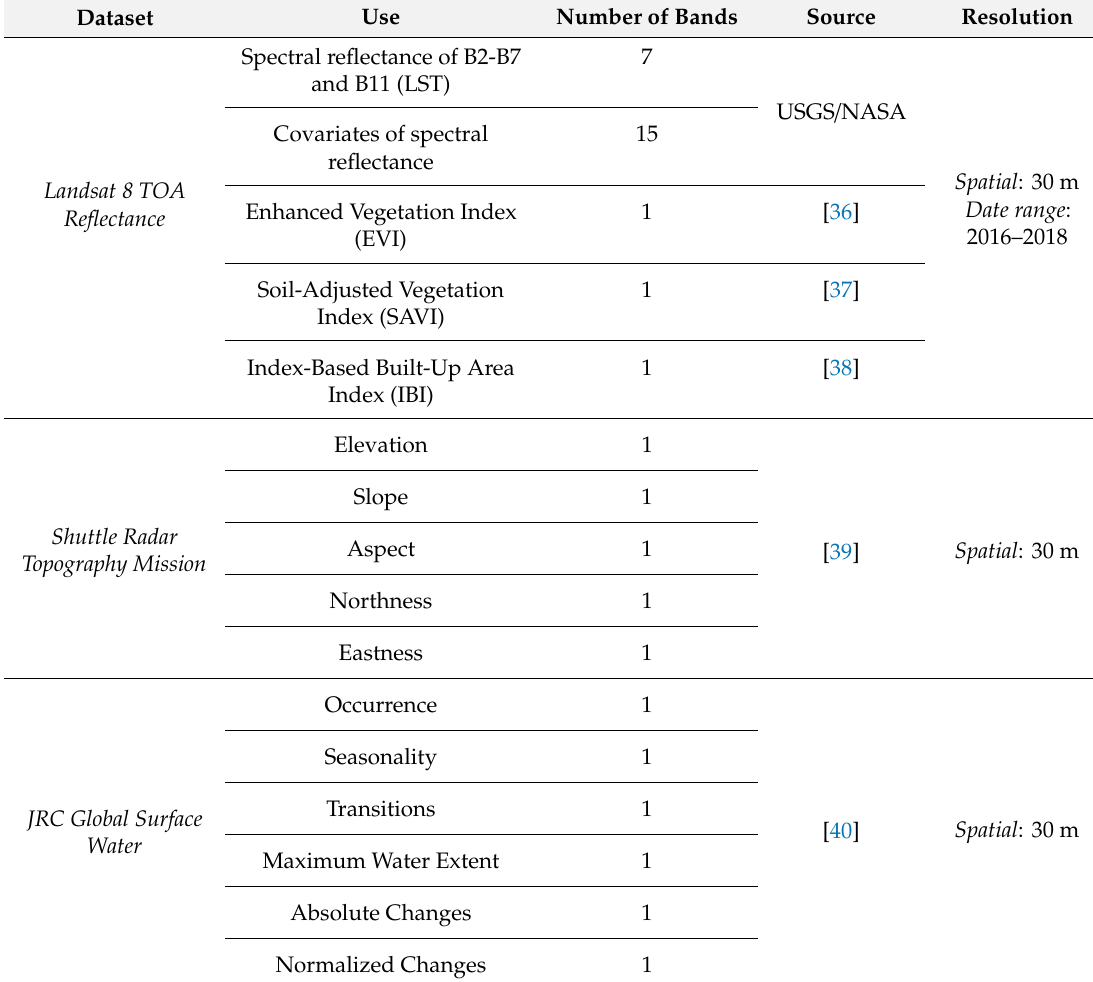
Table 1. Datasets used in commodity